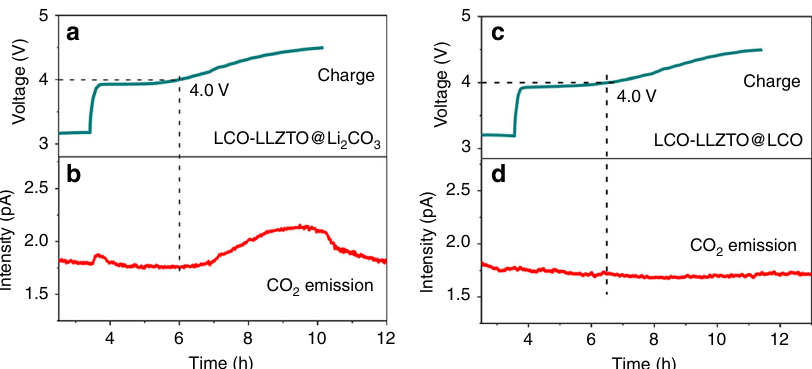
Fig. 6 DEMS analysis of LLZTO@Li 2 CO 3 and LLZTO@LCO in composite cathodes. a , b Charge curves (top) and corresponding CO 2 emission (bottom) of LCO-LLZTO@Li 2 CO 3 and LCO-LLZTO@LCO